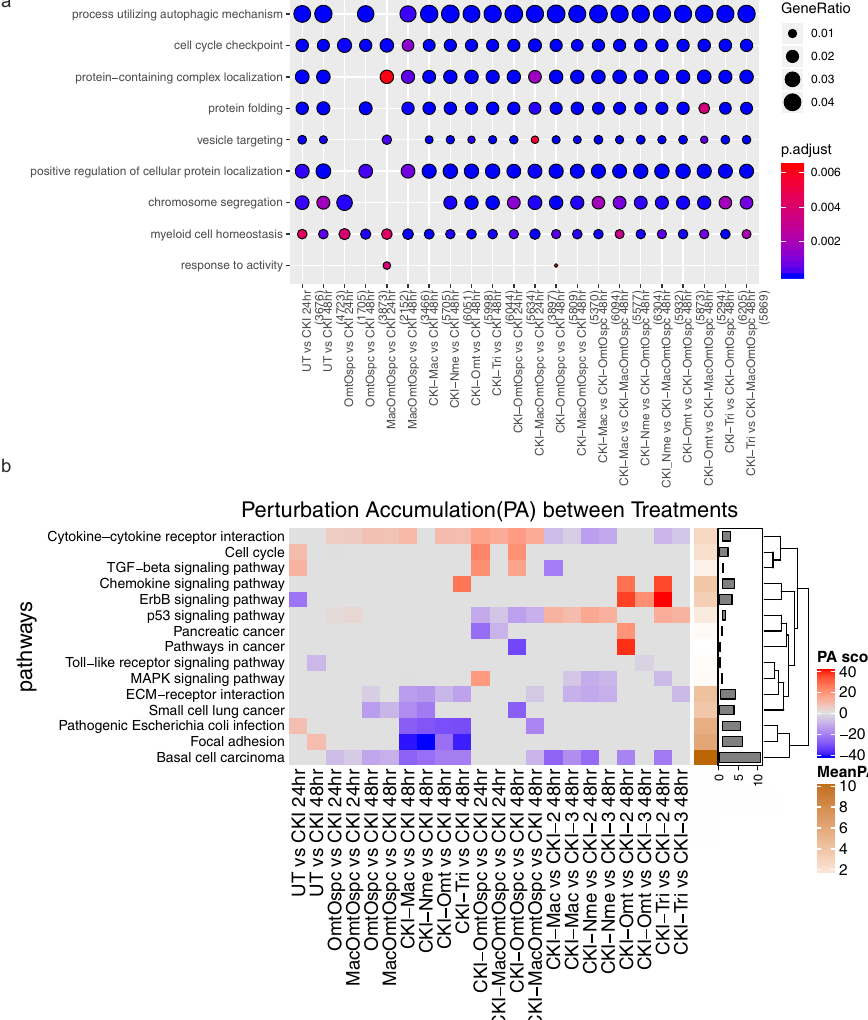
Figure 5. Over-representation analysis of GO functional annotation and KEGG pathway perturbation analysis. ( a ) Over-represented GO terms (Biological Process at level 3) for DE genes identified from comparison of subtractive fraction-treated cells against CKI treatment in order to show the relative change from depleting compounds. Gene ratio of each term calculated from clusterProfiler was plotted based on the adjusted p-values. The top 5 most statistically significantly over-represented categories of GO terms were plotted by default. Colour gradient of adjusted p-values ranging from red to blue in order of increasing p-values (high to low significance). Number of identified genes in each treatment (numbers in parentheses) were shown in the bottom and the sizes of the dots correspond to the ratio of genes out of all significant DE gene from each treatment involved in the particular terms. ( b ) Identification of significantly perturbed pathways using SPIA (pG < 0.05) analysis. Eighty- nine significantly perturbed pathways from twenty-two comparisons were found (Supplementary Fig. 10). Only the 15 pathways most obviously linked to our phenotypes of cell viability, cell-cycle and apoptosis were shown here. Positive (overall increase in gene expression for pathway) and negative (overall decrease in gene expression for pathway) perturbation accumulation values of the pathways were shown in red and blue, respectively. Mean perturbation values of each pathway were shown in bar